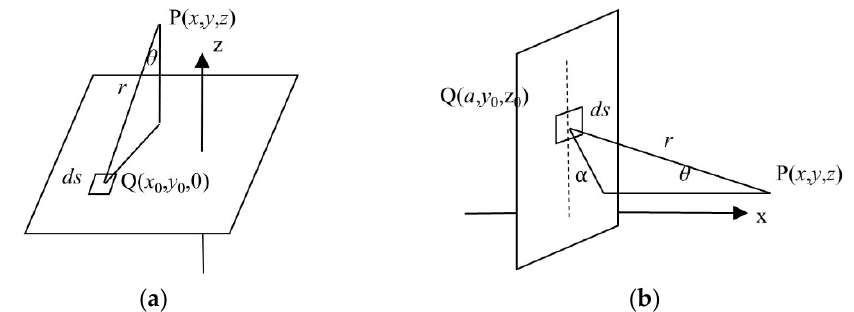
Figure 3. Schematic diagram of the vertical ( a ) and horizontal ( b ) magnetic charge surface that generates the space magnetic field.